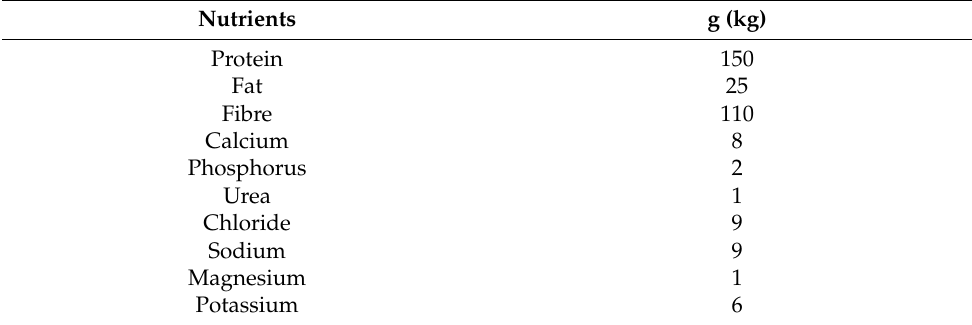
Table 1. Nutrient composition of the commercial diet. Nutrients g (kg) Protein 150 Fat